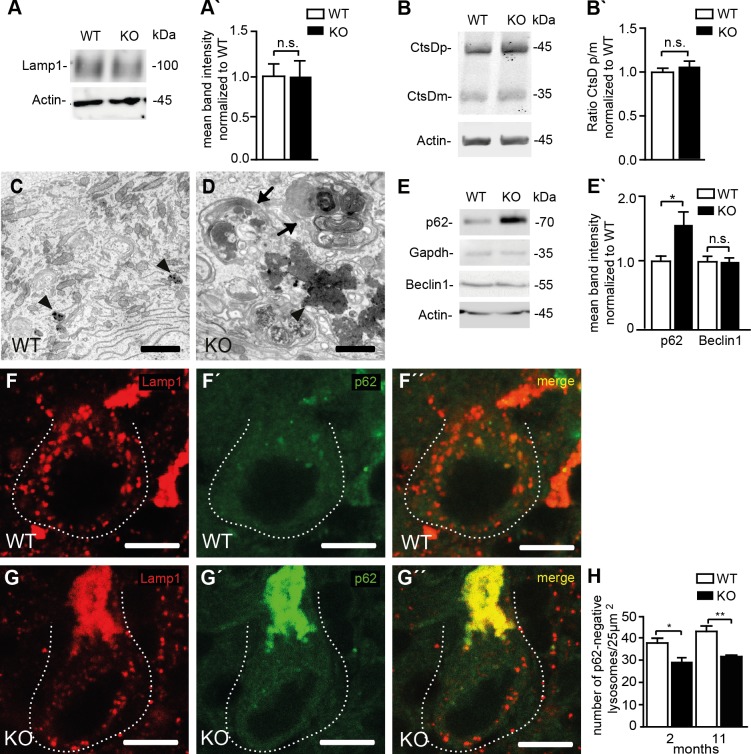
Reduced lysosome numbers in Purkinje cells of Spatacsin knockout mice are consistent with impaired autophagic lysosome reformation.
(A, A´) Overall Lamp1 levels are not changed in Spatacsin KO brains (Mean±SEM of n = 3 experiments; Student’s t-test: n.s. indicates not significant). (B, B´) Lysosomal processing of the lysosomal protease Cathepsin D (CtsDp: precursor; CtsDm: mature) is not impaired in brain lysates of Spatacsin KO mice (Mean±SEM of n = 3 experiments; Student’s t-test: n.s. indicates not significant). (C, D) The ultrastructural analysis of KO Purkinje cells reveals clusters of vesicular structures filled with autophagic material (arrows) and irregularly shaped electron-dense lipofuscin-like deposits (D, arrowhead), while only some lipofuscin particles are found in WT (C, arrowheads). Scale bars: 2 μm. (E, E´) Levels of p62, a marker for cargo destined to be degraded by autophagy, are increased in Triton X-100 insoluble brain fractions of 16 months old Spatacsin KO mice, while Beclin 1, a key protein for the formation of autophagosomes, is not changed (Mean±SEM; n = 3 experiments; Student’s t-test: n.s. indicates not significant; * indicates p<0.05). (F-H) Lysosomes defined as vesicles positive for Lamp1 but negative for p62 are decreased in Purkinje cells of 2-month-old and 11-month-old (displayed in F-G´´) Spatacsin KO mice (Mean±SEM; n = 3 experiments; One-way ANOVA: * indicates p<0.05; ** indicates p<0.005). Scale bar: 10 μm.